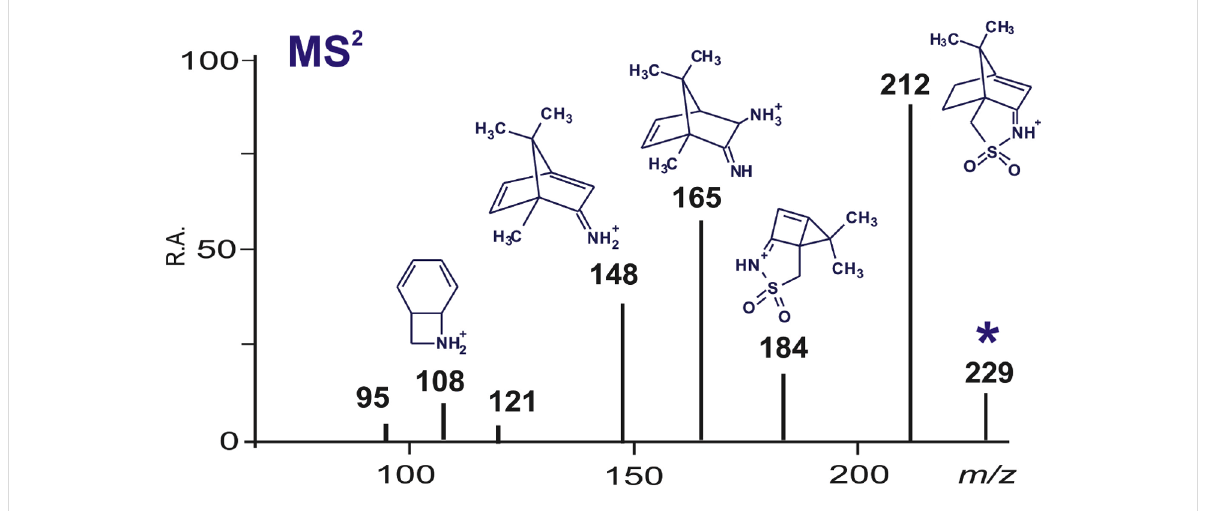
Figure 12: ESI(+) tandem mass spectrum of the intermediate 12 ( m / z 229) and proposed fragment ions.